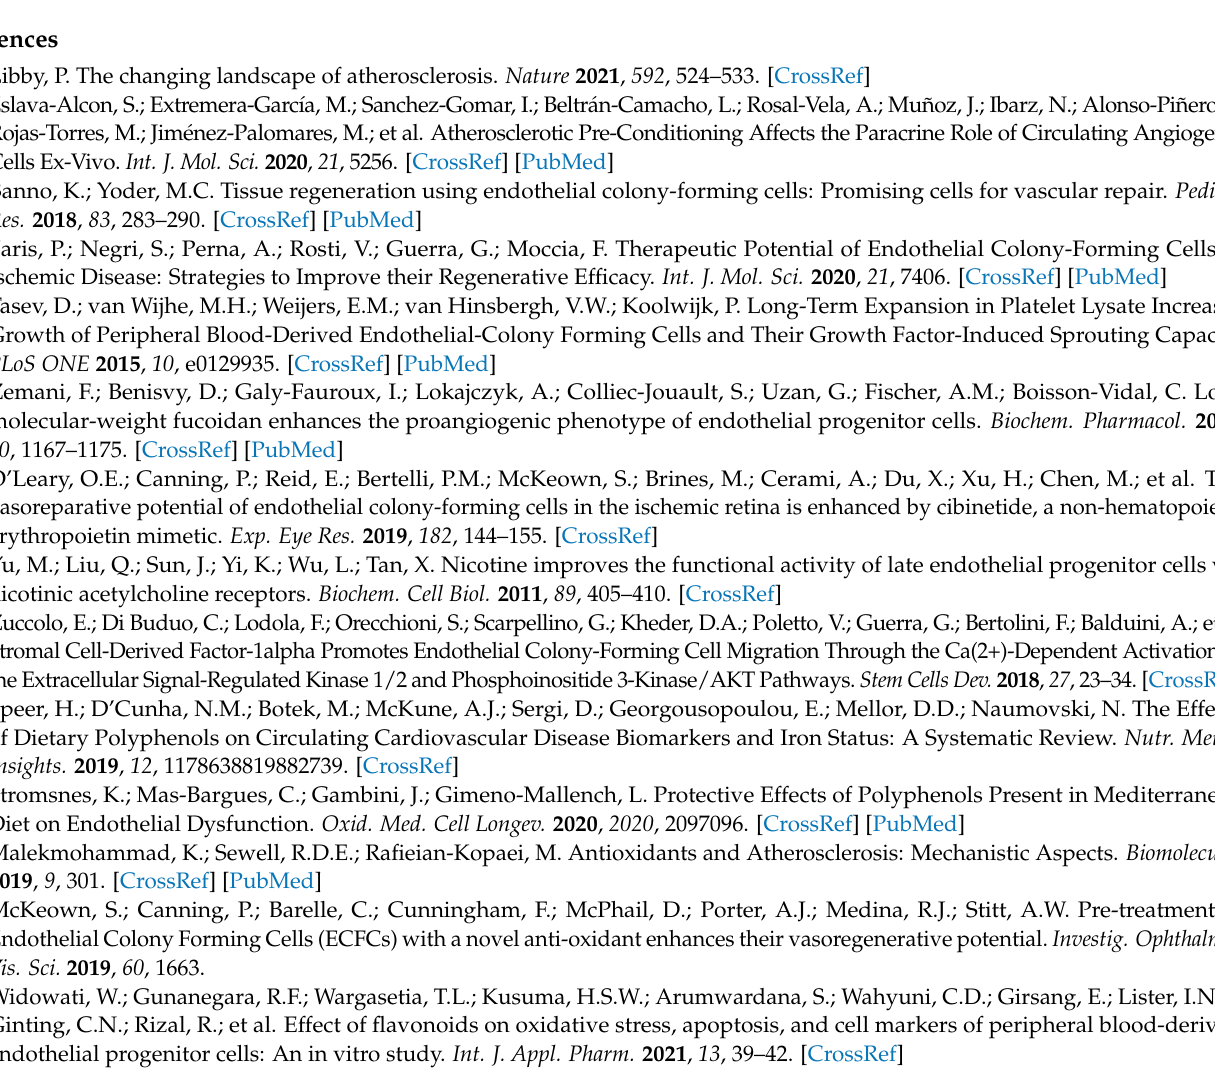
angiogenesis test; Figure S3: Characterization of ECFCs. Table S1: Antibodies used for cytometry analyses and